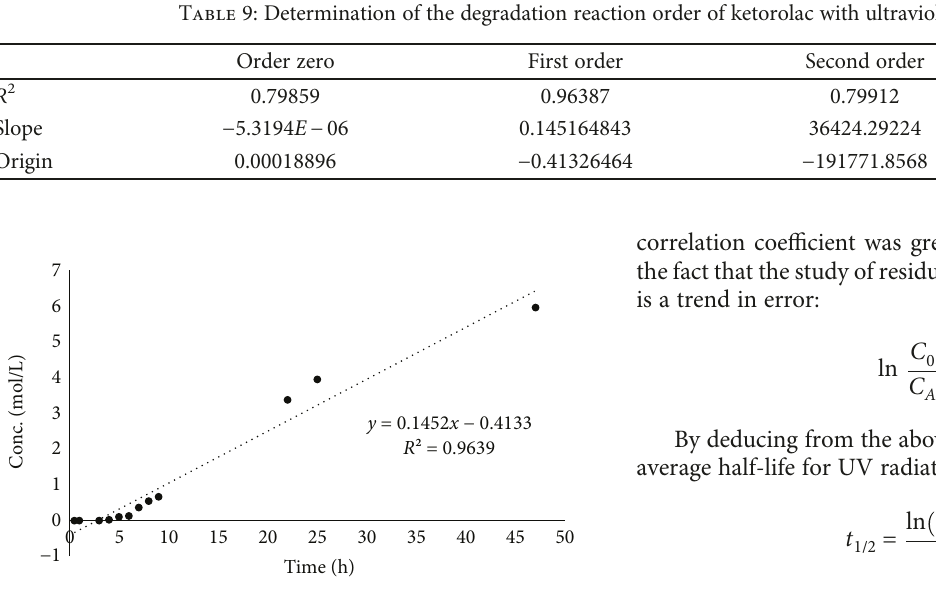
Figure 14: First-order kinetics degradation of ketorolac using UV radiation.